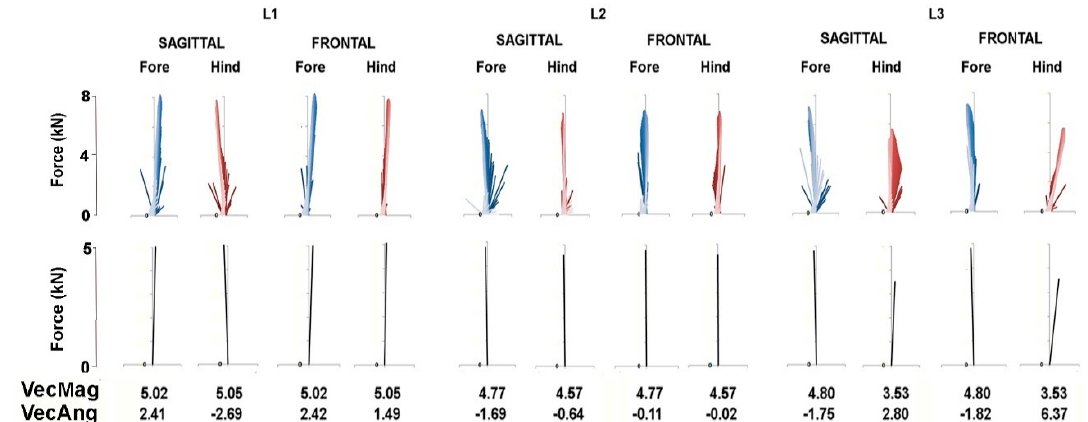
Figure 7. Force vector diagrams (upper panel) of Lusitano horses for the same stance phases as in Figure 4. In the sagittal plane vector diagrams, propulsive longitudinal forces are positive. In the frontal plane vector diagrams, medially directed transverse forces are positive. Summary vectors derived from each vector diagram are shown in the lower panel together with the values for the mean vector magnitude (VecMag) and mean vector angle (VecAng).